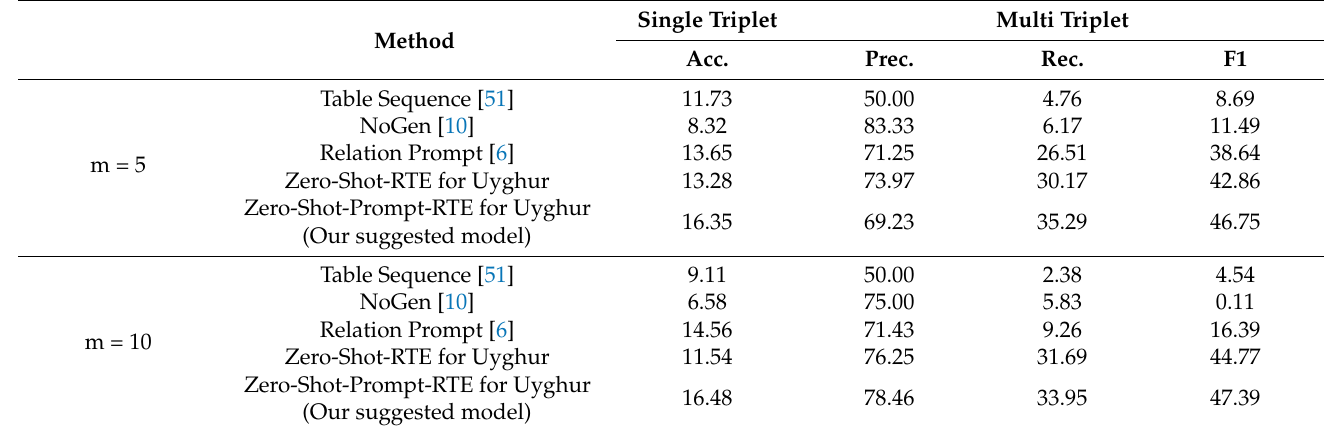
Table 5. Results for our method in different relation types in Uyghur